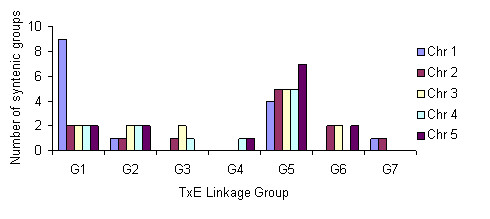
Number of syntenic groups in each TxE linkage group that match to each Arabidopsis chromosome.